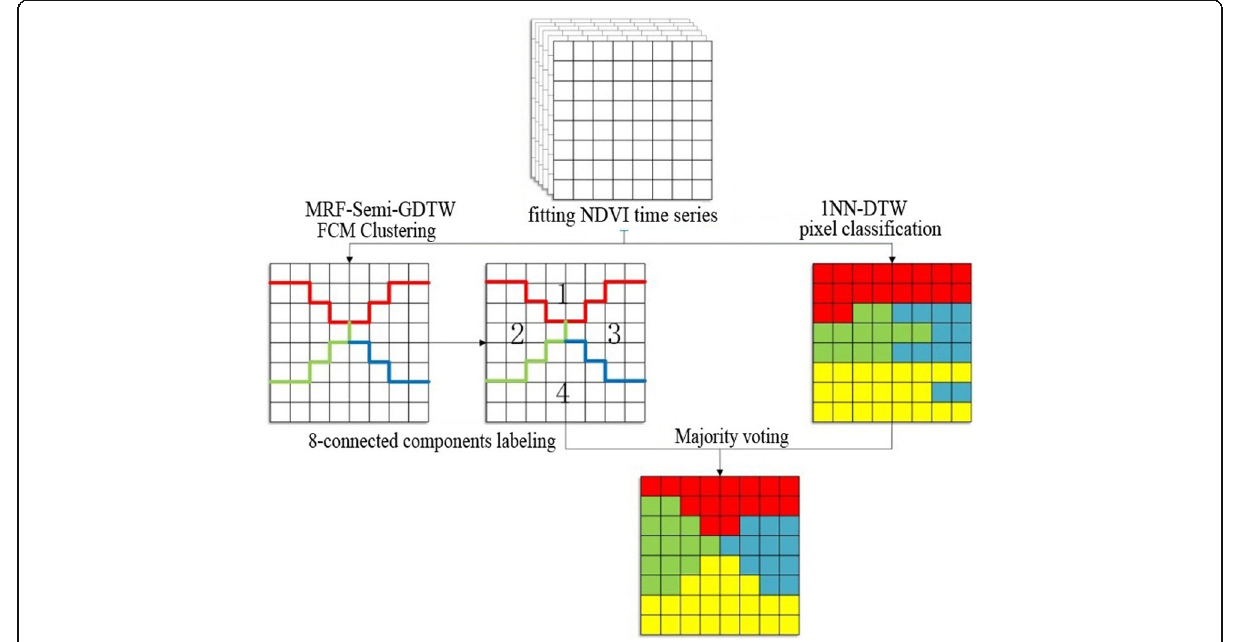
Fig. 2 Diagram for fusion of cluster information and pixel classification